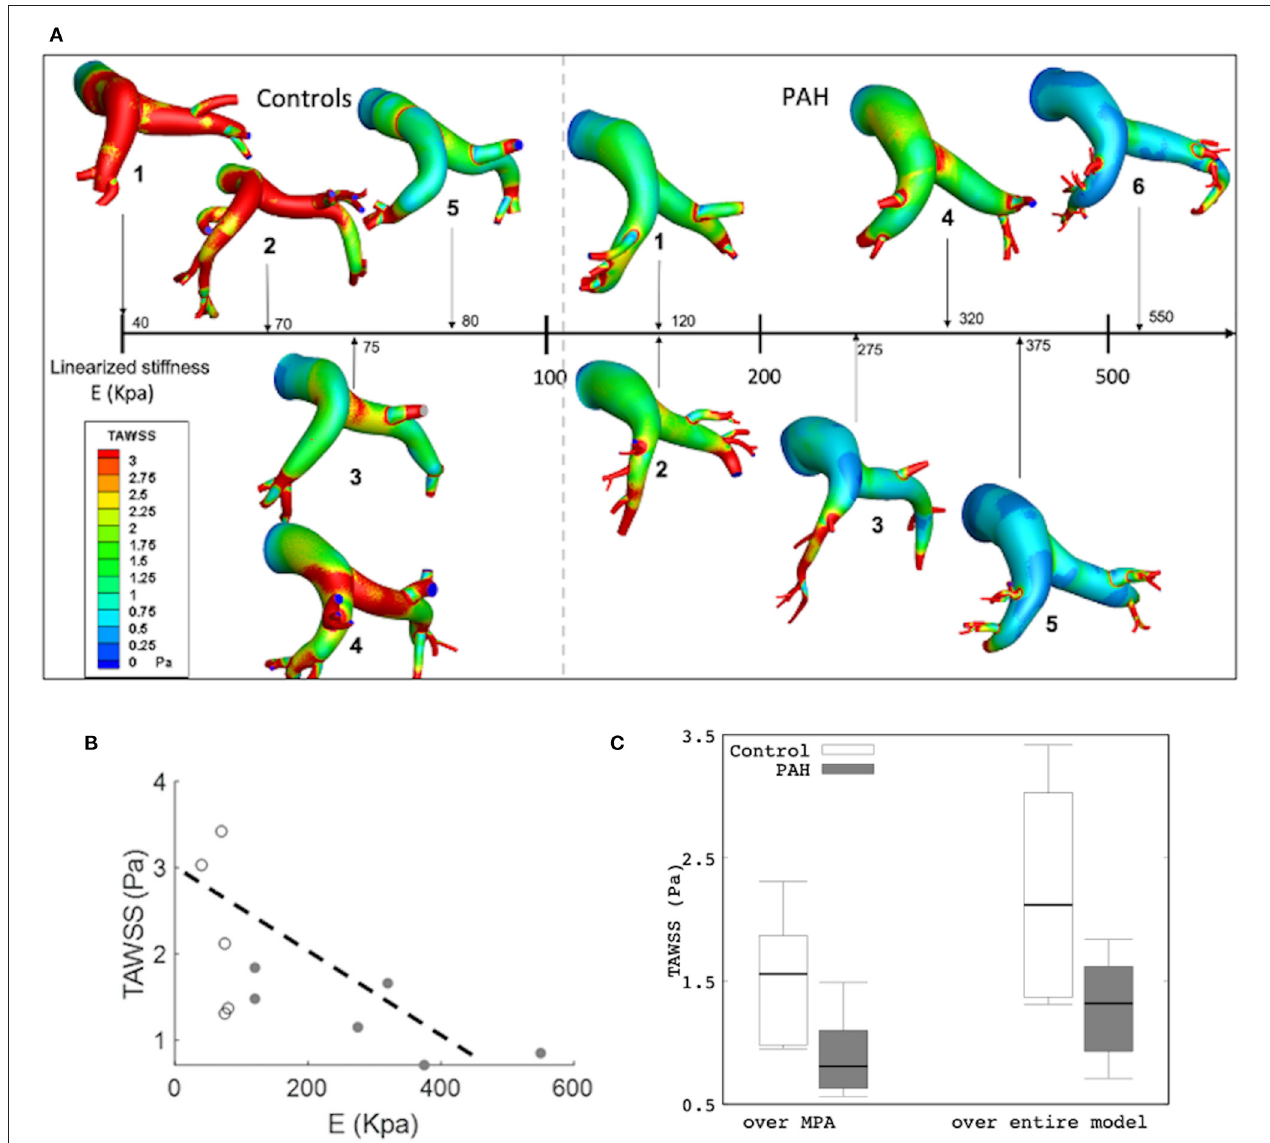
FIGURE 7 | (A) Color-coded spatial distribution of TAWSS for all subjects (control and PAH) arranged with increasing linearized stiffness E . (B) Averaged TAWSS (over the entire model) as a function of E showing a weaker correlation ( r subjects, respectively. Control (white) and PAH (gray). (C) Comparison of TAWSS averaged over the MPA (control: median: 1.56Pa, IQR: 0.89Pa vs. PAH: median: 0.81Pa, IQR: 0.47Pa) and over the entire model (median: 1.32 Pa, IQR: 0.69 Pa vs. median: 2.12 Pa, IQR: 1.66 P; P